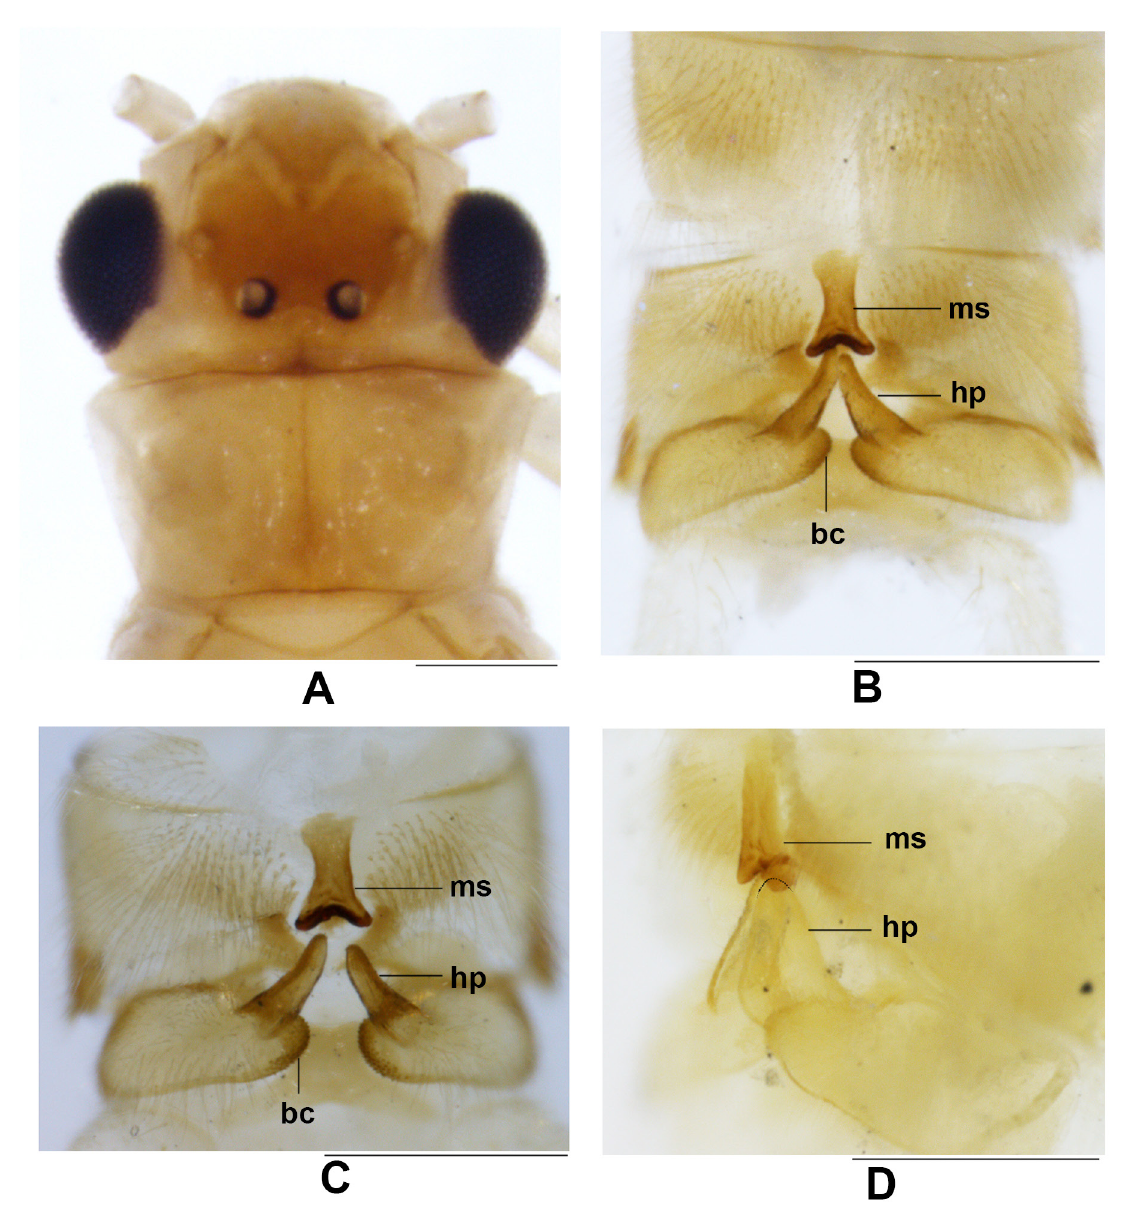
Fig. 1. Chinoperla changjiangensis sp. nov., ♂, paratype (HIST). A . Head and pronotum, dorsal view. B . Terminalia, dorsal view. C . Cleared terminalia, dorsal view. D . Cleared terminalia, lateral view. Abbreviations: see Material and methods. Scale bars = 0.5